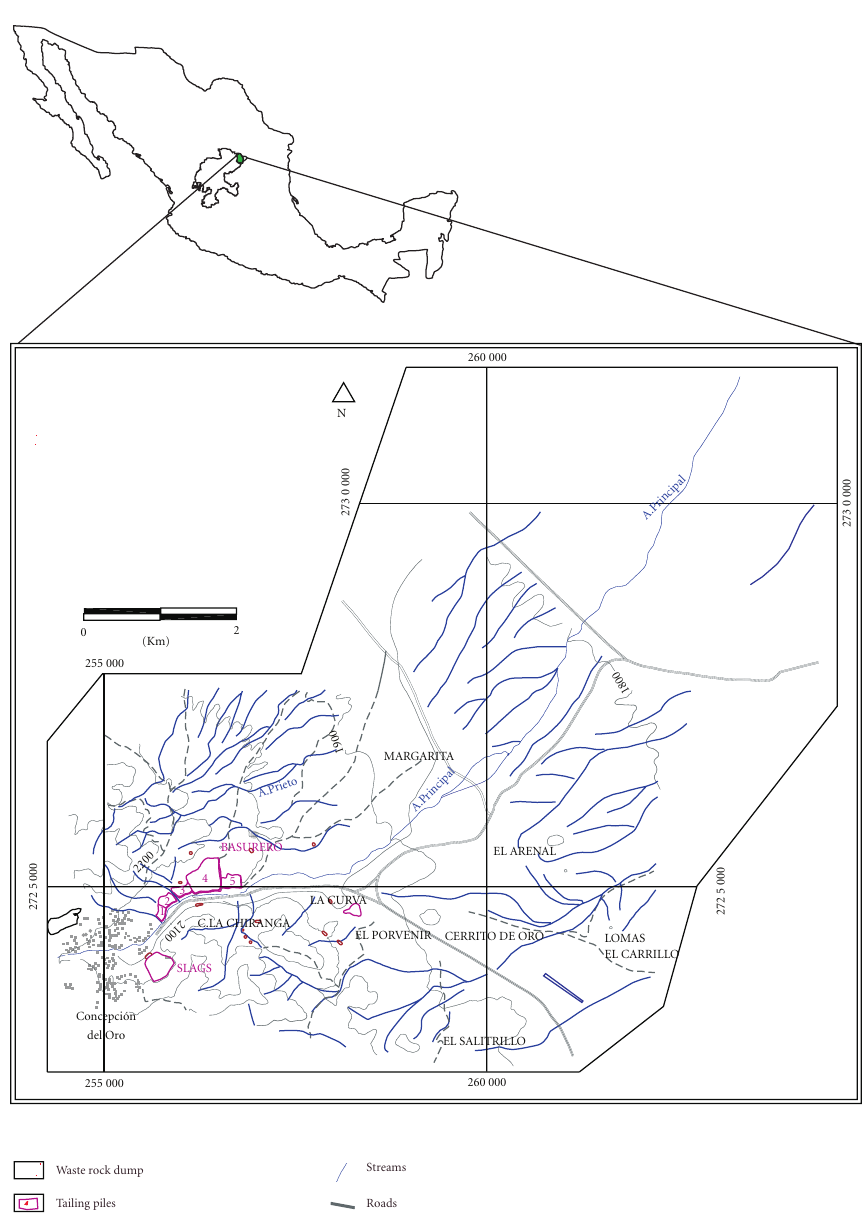
Figure 1: Location of the Concepci´on del Oro mining area (Zacatecas, North-Central